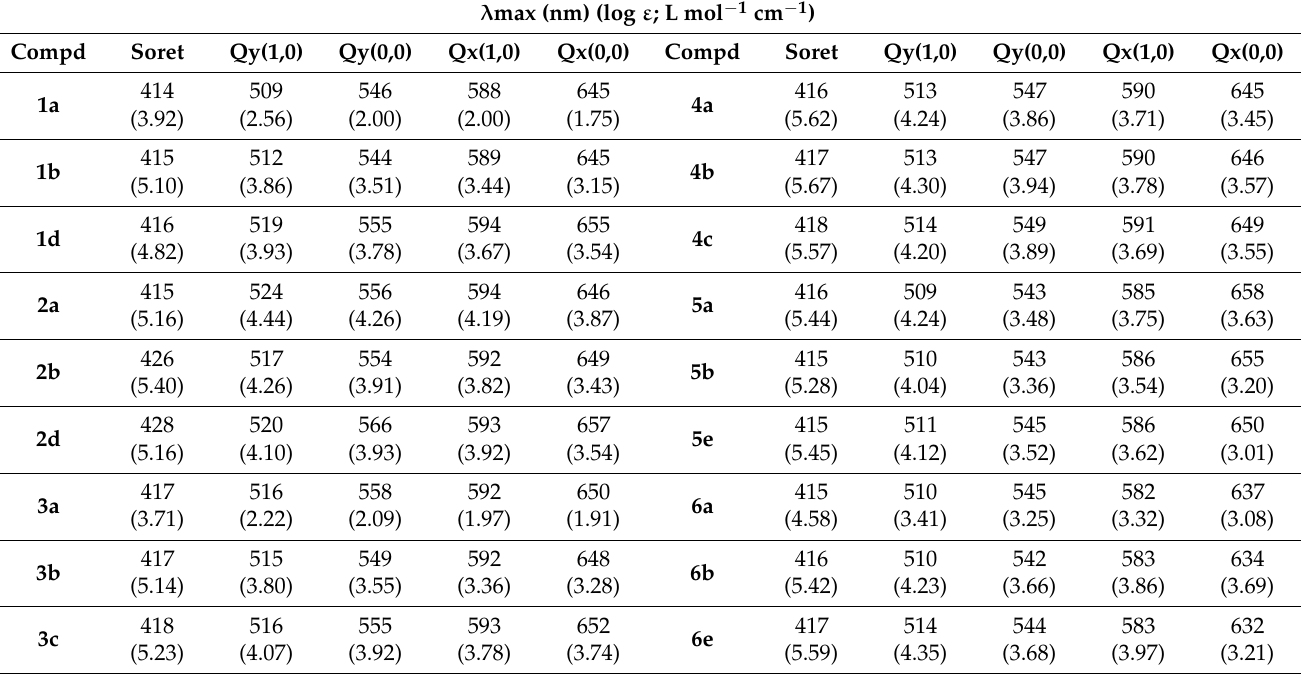
Table 3. Maximum absorbance wavelengths ( λ , nm) and molar absorptivities (log ε , L mol − 1 cm − 1 ) of the cationic porphyrins in ethanol